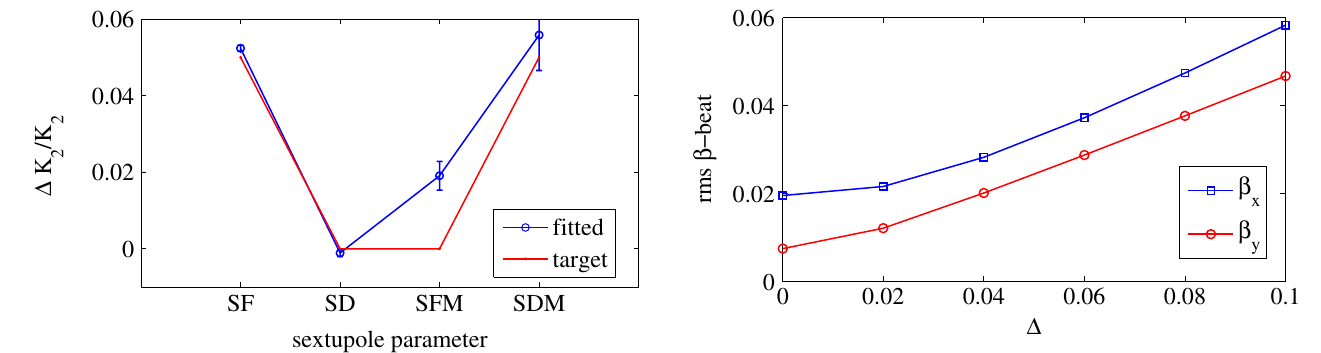
FIG. 6. The fitted sextupole parameters are compared to the expected values.